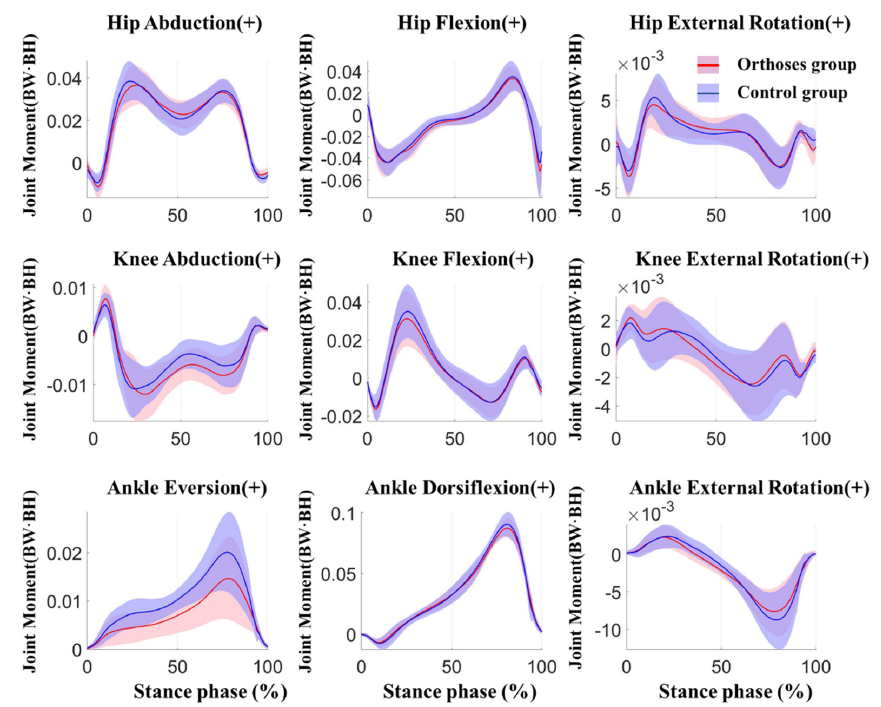
Figure 5. Joint moments of the lower limb in the orthoses group (red) and control group (blue) during stance phase. Shaded area ± 1 std.